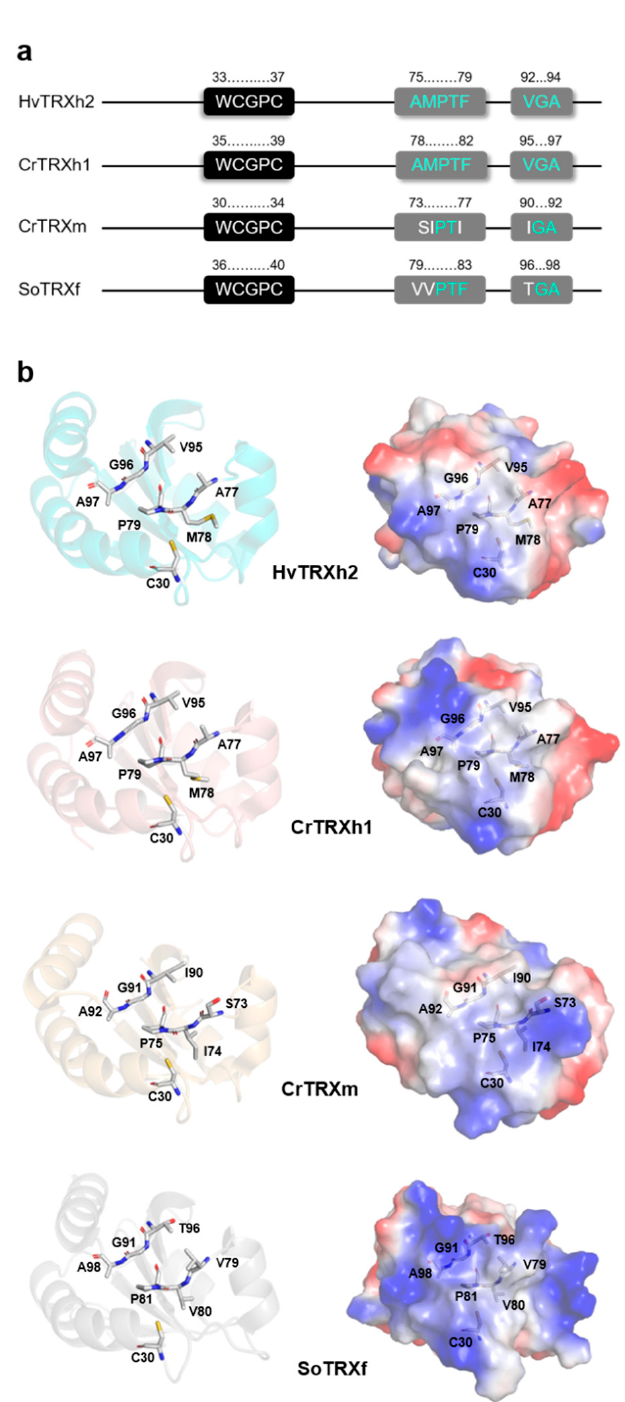
Figure 2. Sequence and structural analysis of the substrate recognition loop (SRL). ( a ) Schematic representation of the substrate recognition loop in HvTRXh2, CrTRXh1, CrTRXm, and SoTRXf. The active site motifs are highlighted in black, whereas the cis -Pro and Gly loops are highlighted in gray, with conserved and non-conserved residues indicated in cyan and white, respectively. The size of the strings is not proportional to the length in amino acids. ( b ) Ribbon representation of HvTRXh2, CrTRXh1, CrTRXm, and SoTRXf highlighting the residues forming the cis -Pro and Gly loops. ( c ) Electrostatic surface potentials were computed with the Adaptive Poisson-Boltzmann Solver (APBS) Electrostatics plugin in PyMOL (red for electronegative, white for neutral, blue for electropositive).